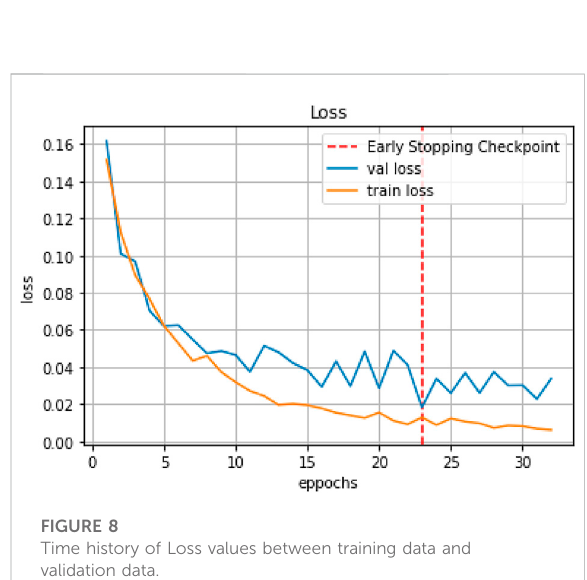
FIGURE 8 Time history of Loss values between training data and validation data.